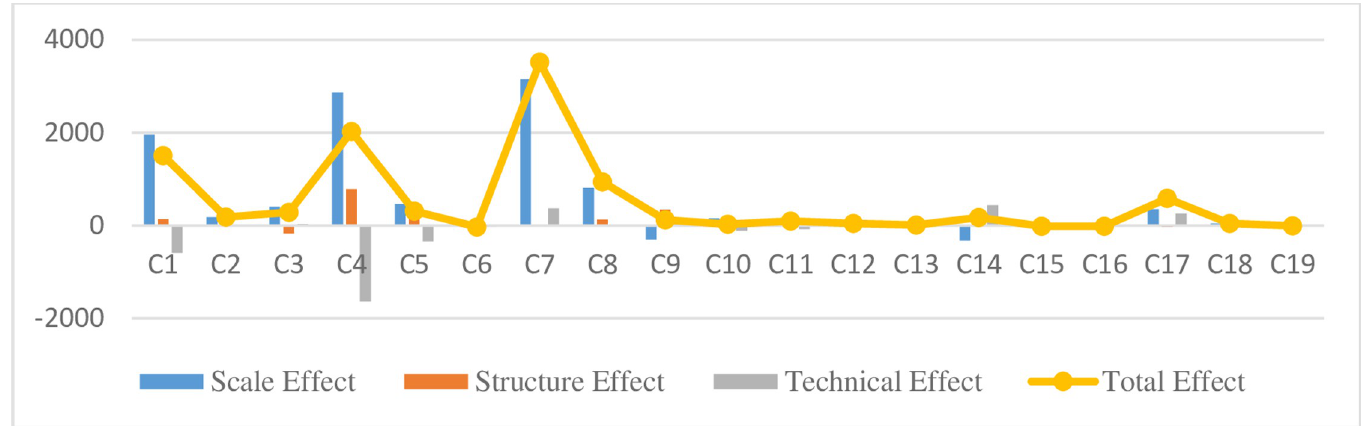
Fig 2. Decomposition of factors affecting embodied waste gas emissions (unit: 100 million cubic